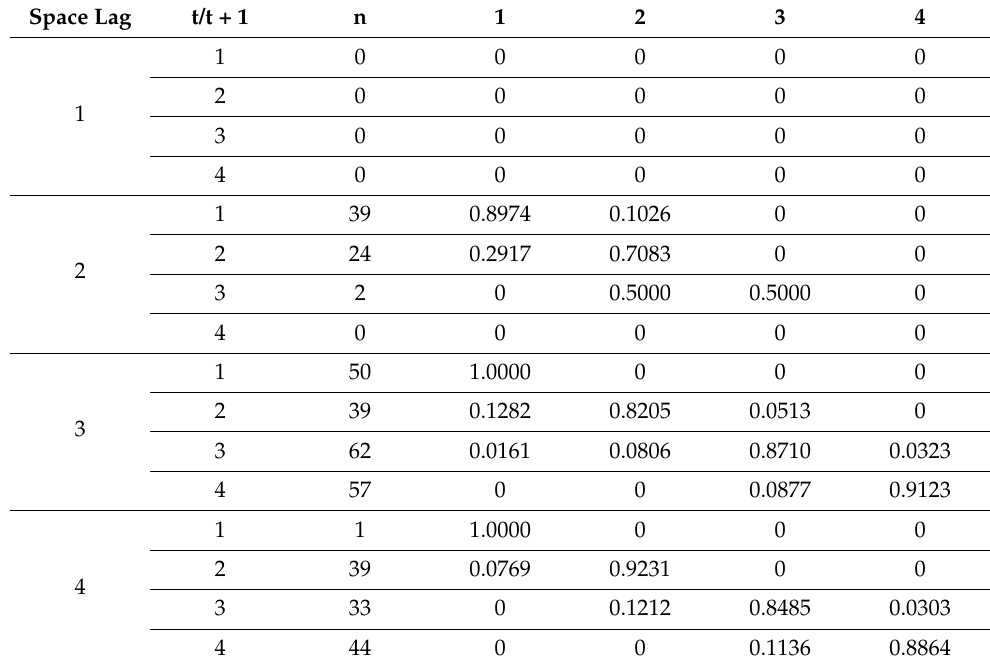
Table 3. Spatial Markov probability transfer matrix of ecological well-being performance in China. Space Lag t/t +